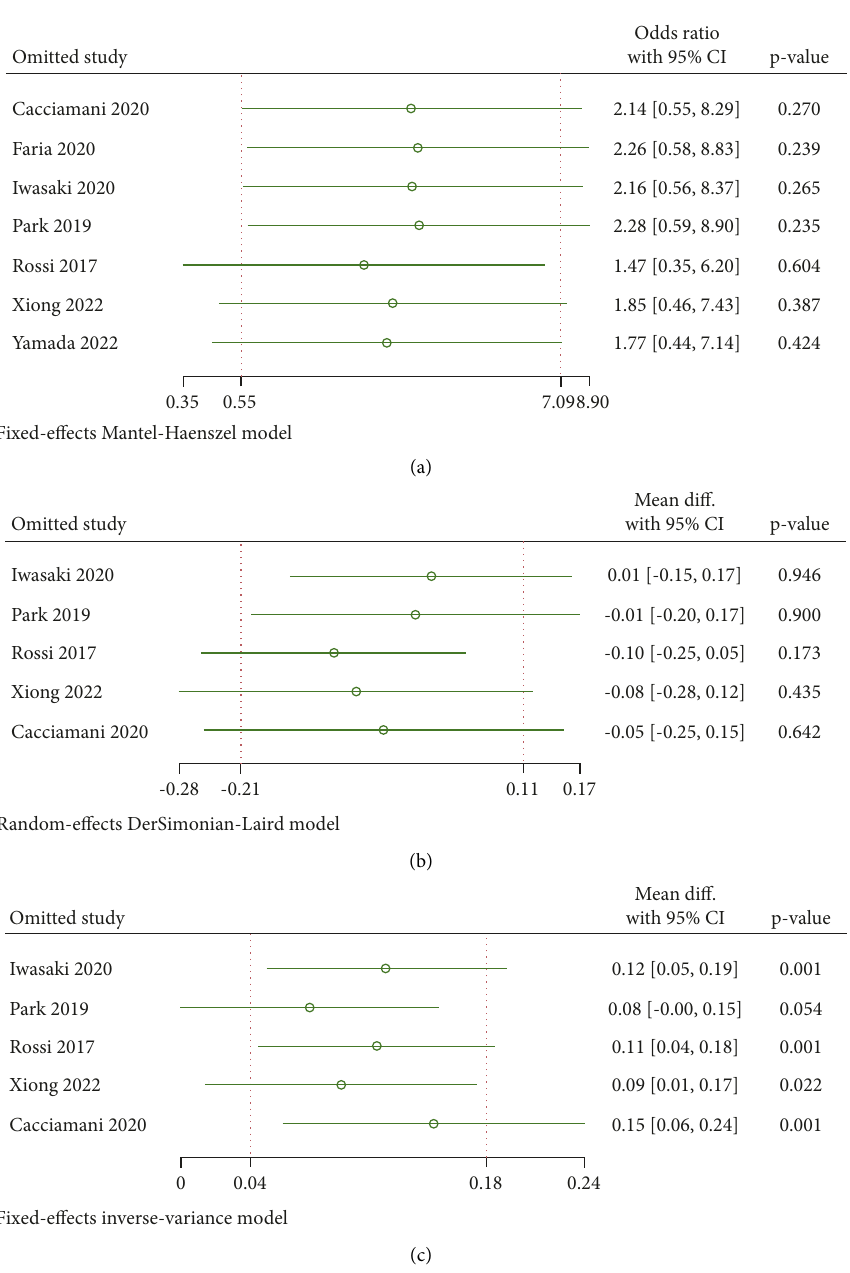
Figure 7: Sensitivity analysis, given named study is omitted. (a) MH closure rate. (b) Preoperative BCVA in logMAR. (c) Postoperative BCVA in